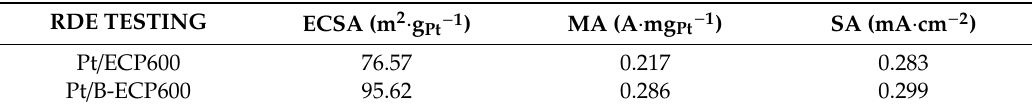
Figure 5. Electrocatalytic properties of the prepared catalysts: ( a ) Cyclic voltammogram (CV) curves and ( b ) linear sweep voltammetry (LSV) polarization curves of Pt/B-ECP600 and Pt/ECP600. Table 1. The electrochemically-active surface area (ECSA), mass activity (MA), and area specific activity (SA) of Pt / ECP600 and Pt /